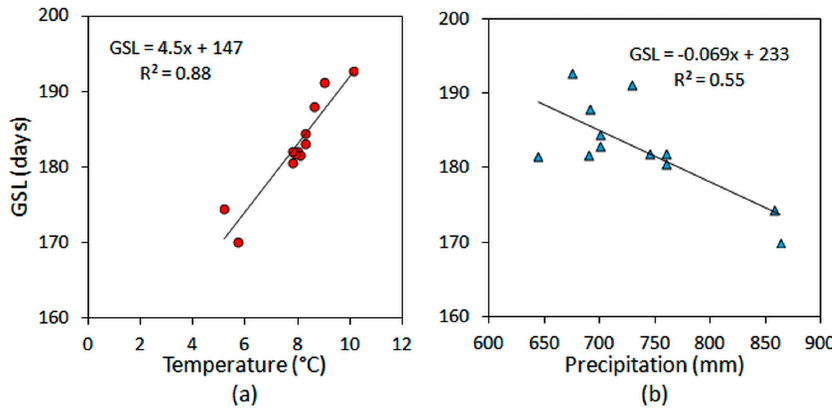
Figure 9. Growing season length in the twelve study stands in relation with normal temperature ( a ) and precipitation ( b ).